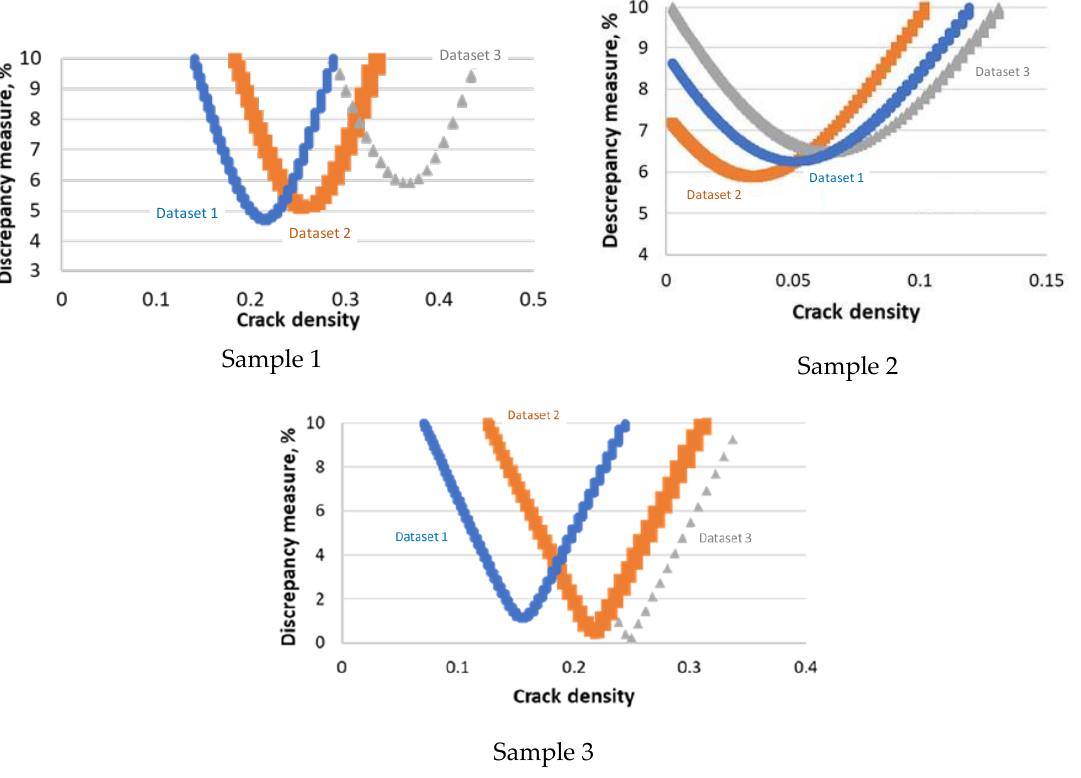
Figure 14. The Discrepancy measure versus density of microcracks for three sets of input data for Samples 1 – 3.